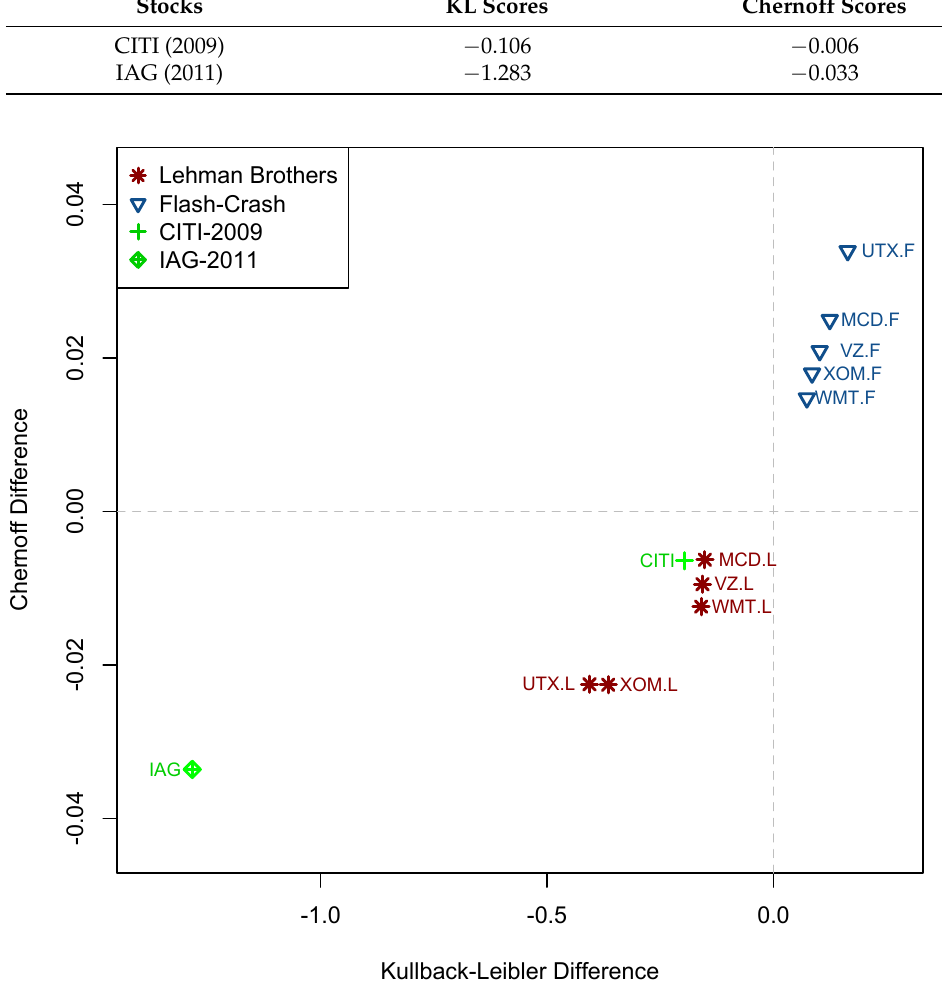
Figure 7. Classification (by quadrant) of Lehman Brothers collapse and flash crash event using the Chernoff and Kullback–Leibler